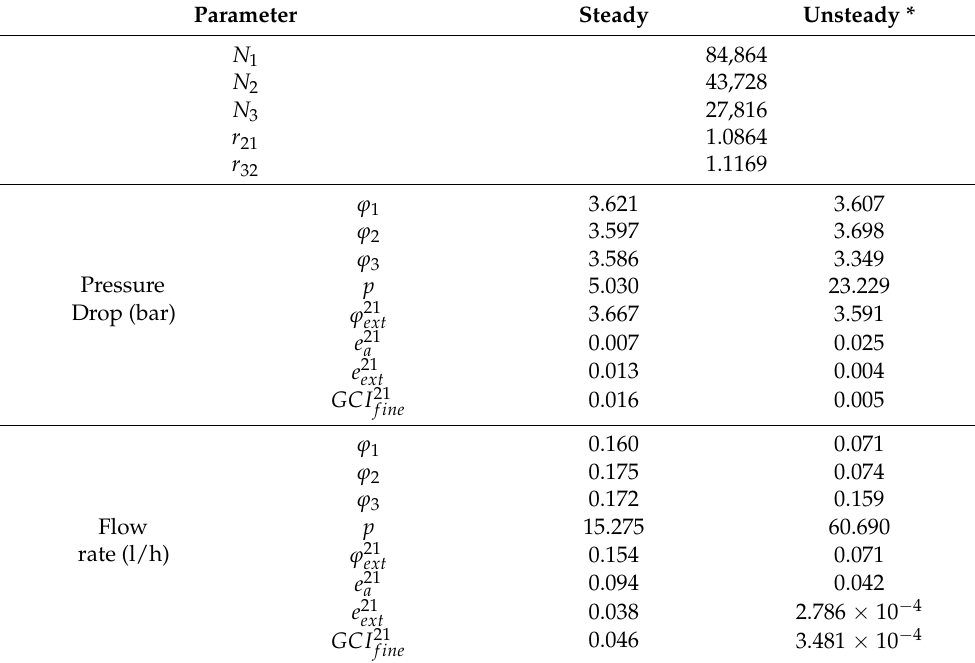
Table 4. Results of mesh independence with the GCI parameters were calculated for the two different cases with the three defined meshes. N 1 , N 2 , and N 3 are the element counts from the most refined mesh ( N 1 ) to the coarser mesh ( N 3